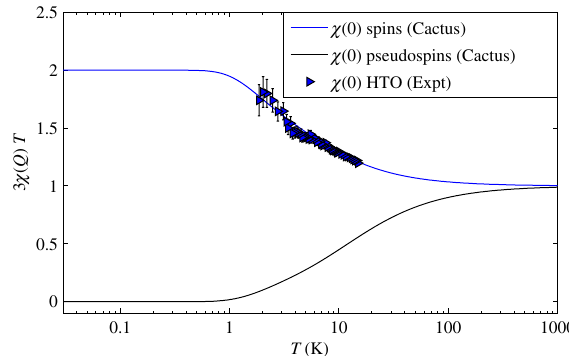
T for 0 Ti O . (See text for 2 2 7